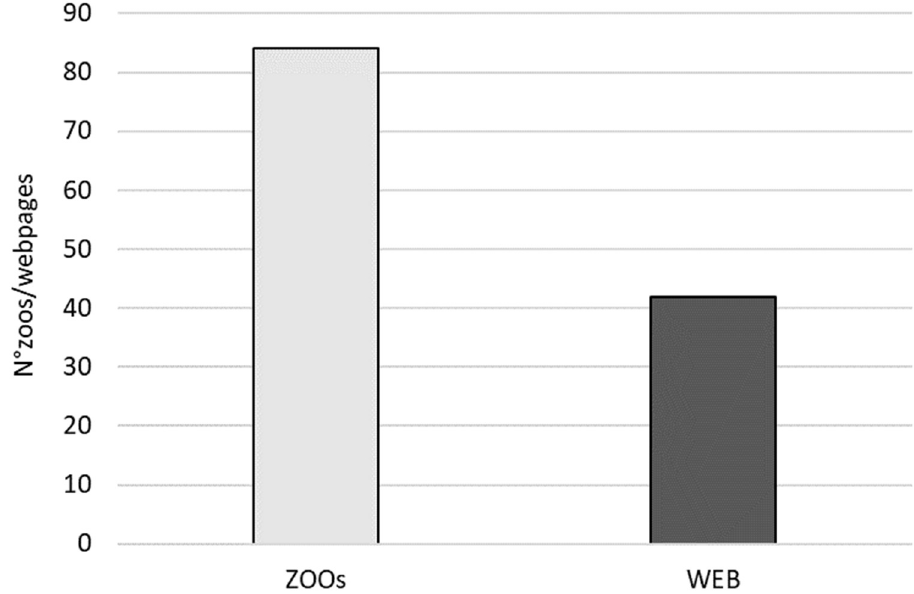
Figure 1. The number of zoos involved in all 12 conservation projects (ZOOs) and the number of webpages on websites of zoos involved (WEB).